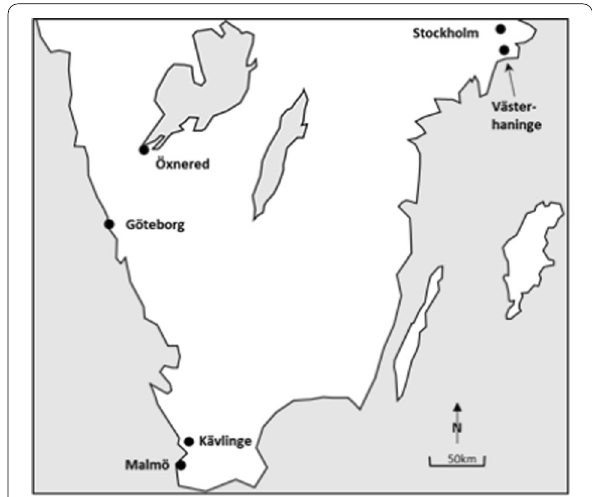
Fig. 1 Location of Öxnered, Kävlinge and